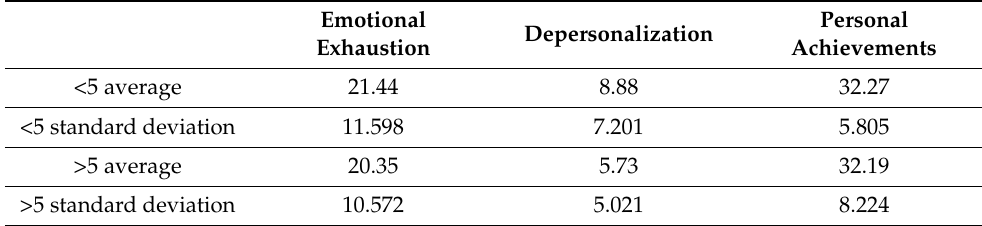
Table 5. Basic statistical calculations for individuals working less than 5 years, N = 41, and more than 5 years, N = 88.